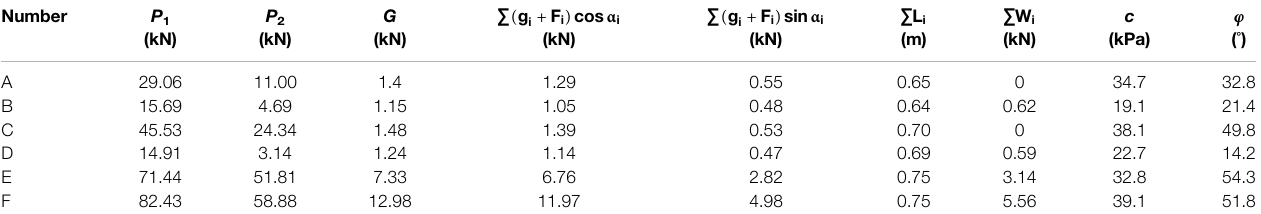
TABLE 2 | In-situ test results and shear strength indicators of clay-gravel layer. Number